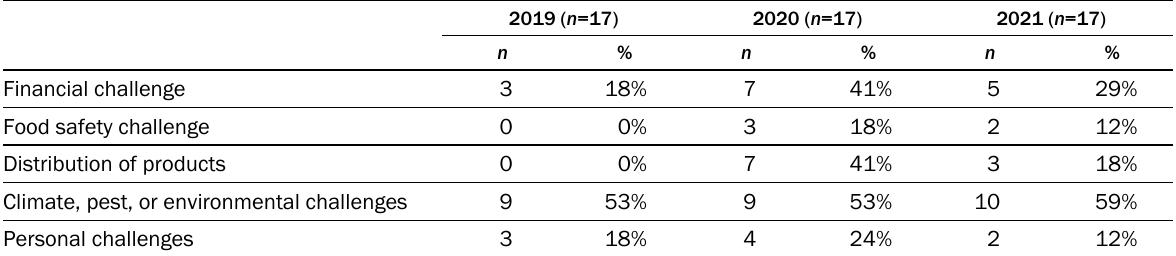
Table 3. Responses to the Question: “ Which of these, if any, did your farm/business struggle with? Choose all that apply.